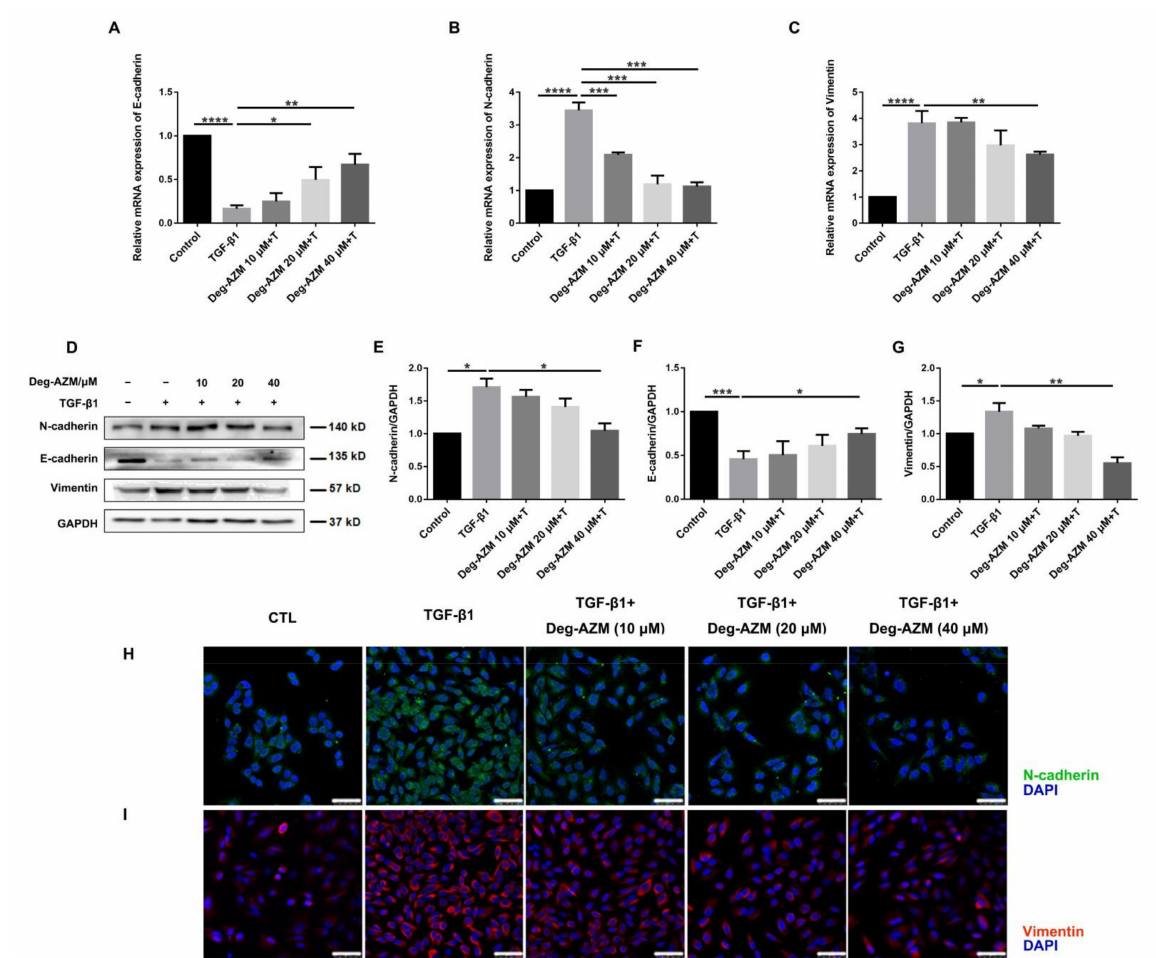
Figure 6. Deglycosylated azithromycin inhibits TGF- β 1-induced EMT in epithelial cells. ( A – C ) A549 cells were exposed to deglycosylated azithromycin for 30 min (10, 20, and 40 µ M) and treated with TGF- β 1 (5 ng/mL) for 24 h. The mRNA levels were detected: E-cadherin, N-cadherin and Vimentin were tested by RT-PCR in A549 cells, ( n = 3 per group). ( D ) A549 cells were treated with TGF- β 1 (5 ng/mL) and deglycosylated azithromycin (10, 20 and 40 µ M) for 24 h. Protein expression levels of N-cadherin, E-cadherin and Vimentin were assessed by Western blot. ( E – G ) Densitometric analysis of N-cadherin, E-cadherin and Vimentin, using GAPDH as the internal reference. ( H , I ) A549 cells treated with TGF- β 1 (5 ng/mL) and deglycosylated azithromycin (10, 20 and 40 µ M) for 24 h were immunostained with N-cadherin and Vimentin. Scale bar = 20 µ m. Data are presented as the means ± SD ( n = 3). Comparisons between groups were achieved using one-way analysis of variance (ANOVA). * p < 0.05, ** p < 0.01, *** p < 0.001, **** p <